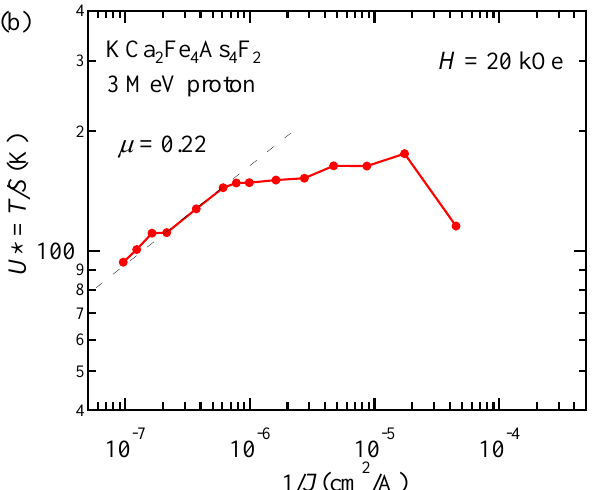
Figure 8. Inverse current density dependence of effective pinning energy U * at H = 20 kOe in ( a ) the pristine and ( b ) 3 MeV proton irradiated (3 × 10 16 ions/cm 2 ) KCa 2 Fe 4 As 4 F 2 .